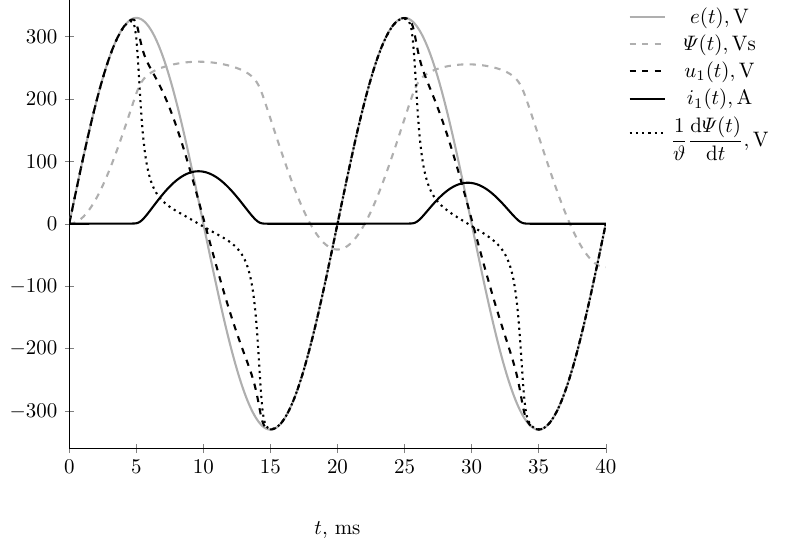
Figure 6. Waveforms of the state variables Ψ ( t ) , i 1 ( t ) obtained from the model along with the quantities expressed by their derivatives, i.e., the electromotive force induced in the secondary winding d Ψ / dt and the supply voltages e ( t ) and u 1 ( t ) at the transformer terminals. The scale of the y-axis is common for the current (A), voltages (V), and flux (Vs).